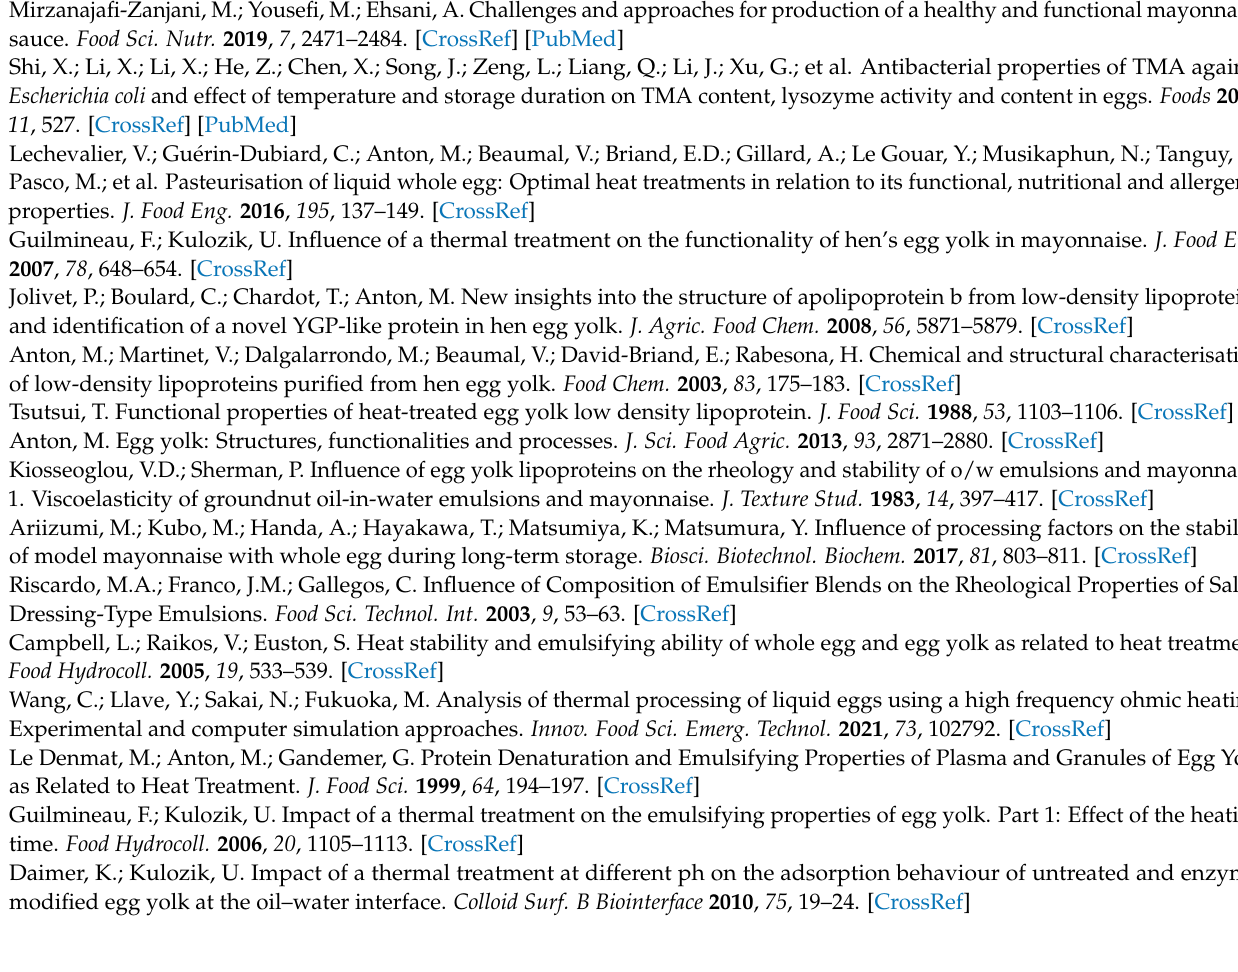
Particle size. Figure S3: Effect of thermal processing on emulsion property of mayonnaise. Figure S4: Effect of thermal processing on mayonnaise rheological properties. Figure S5: Effect of thermal processing on storage properties (acid values) of mayonnaise. Figure S6: Effect of thermal processing on storage properties (TBA values) of